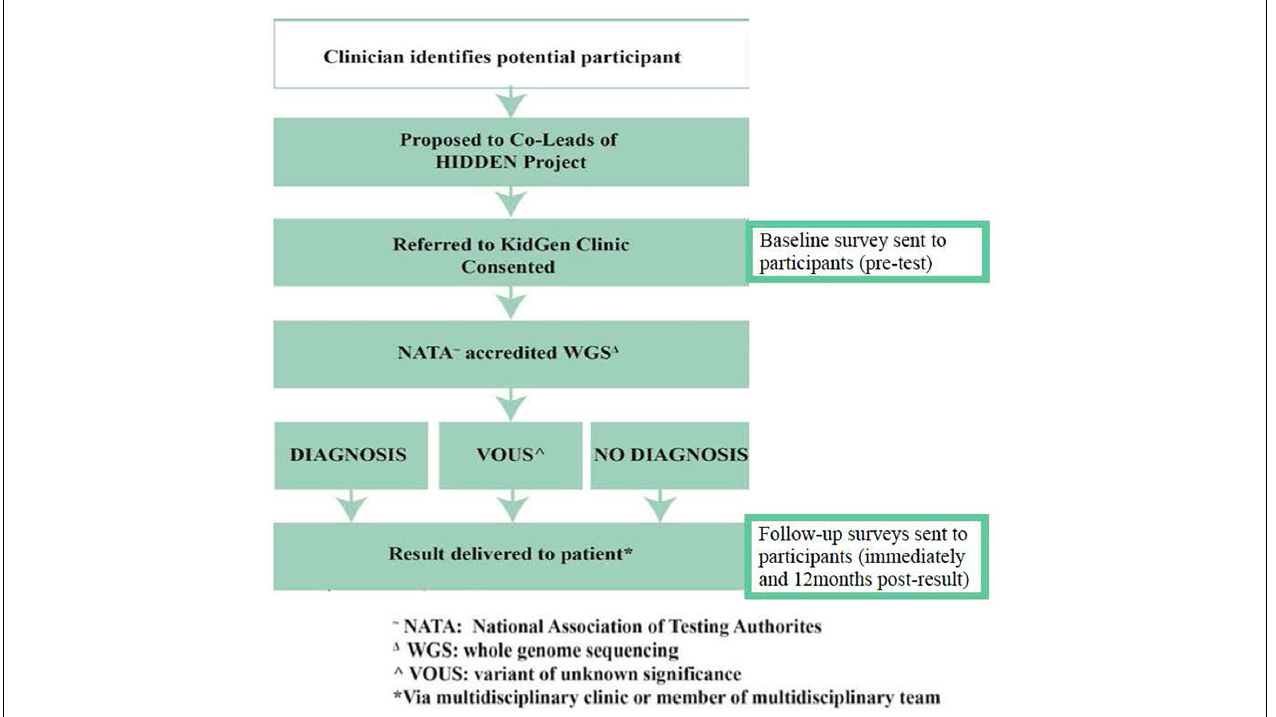
FIGURE 2 | Data collection and WGS workflow for